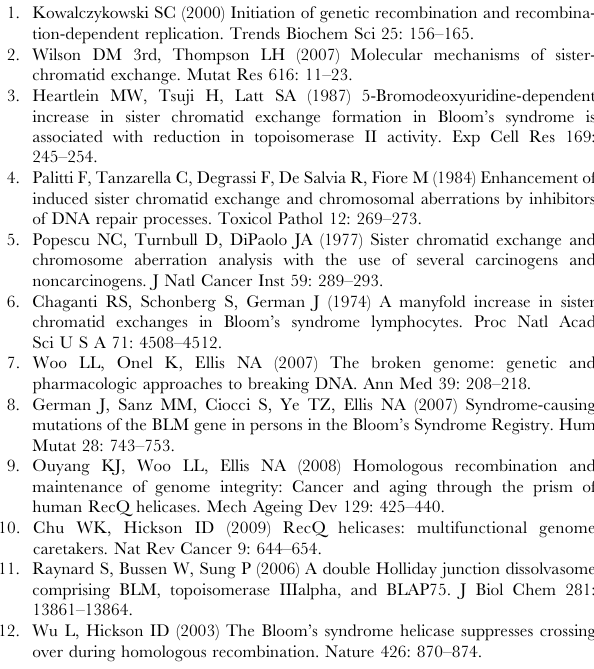
despite the fact that mimosine treatment induces many c -H2AX foci, which has been previously reported [64]. Found at: doi:10.1371/journal.pbio.1000252.s006 (0.01 MB PDF) Figure S7 BLM and SM-BLM localize to stalled replica- tion forks with similar efficiency. (A) Immunofluorescence images of representative S-phase BLM + and SM-BLM cells treated with 0.5 mM HU for 24 h. Cells were stained with antibodies to PCNA. Images show GFP-BLM fluorescence, PCNA staining, and merged BLM-PCNA immunofluorescence. (B) Graphical representation of the average numbers of BLM foci, PCNA foci, and colocalized BLM-PCNA foci in HU-treated BLM + and SM-BLM cells. The numbers of BLM and PCNA foci were counted in cells that stained positively for PCNA, as these represented cells in S phase. Data presented are the average of two experiments in each of two BLM + and two SM-BLM clones. Bars represent the mean numbers of foci or colocalized foci per nucleus, and the error bars represent the standard deviations of the combined data. The levels of BLM foci and PCNA foci were higher in SM-BLM than in BLM + cells; however, the percentages of colocalized BLM-PCNA foci were similar in BLM + and SM- BLM cells, indicating that SUMO-mutant BLM localizes normally to sites of replication damage. Found at: doi:10.1371/journal.pbio.1000252.s007 (0.99 MB